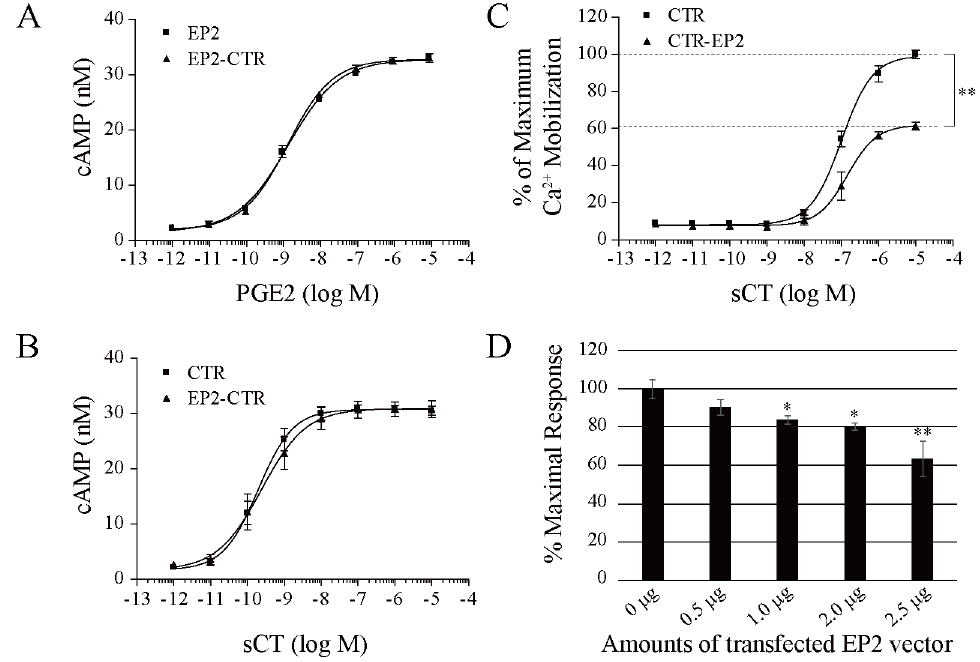
Fig 3. Effect of EP2-CTR heterodimerization on second messenger production. (A-C) 5- μ g each of EP2-V5 and CTR-V5 vectors were transfected individuallyor together into 1 × 10 6 HEK293MSR cells on 60-mm dish. Then, 5 × 10 4 cells were spread onto 96-wellassay plates at the next day and incubatedfor another 24 hr. cAMP production(A, B) and Ca 2+ mobilization (C) were measuredfollowingstimulationwith PGE2 (A) or salmon CT (sCT, B, C) at indicatedconcentration. NeitherPGE2 (A) nor sCT (B) stimulationsignificantly altered cAMP productionby HEK293MSR cells. (C) Ca 2+ mobilization by (cid:21) 10 − 7 M sCT was significantly lower in the EP2-CTR-coexpressingcells than in cells expressingCTR alone. Emax values (dashedlines) between monomer-and heterodimer-expressingcells (100.0% ± 2.5% vs 62.4% ± 5.2%) were analyzedby Student’s t test ( ** , P = 0.0004). (D) Dose-response effects of EP2-expression levels on Ca 2+ mobilization. 2.5 μ g of CTR-V5 and 0, 0.5, 1, 2, or 2.5 μ g of EP2-V5 expressionvectors were transfected into 5 × 10 5 HEK293MSR cells on 35-mm dishes. Ca 2+ mobilization was measured as above followingstimulationwith 1 × 10 6 M sCT. Results are shown as the mean ± SEM from 3 independent transfections.